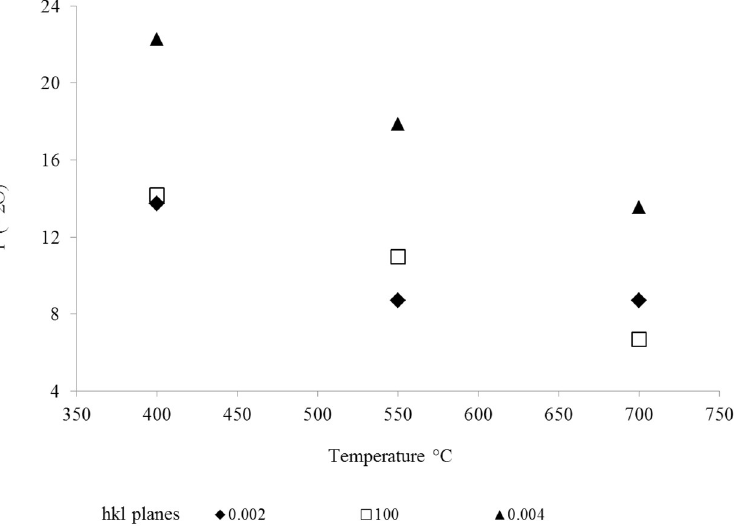
Fig 3. Width of the base of the peak to half-height in 2 Ɵ for the hkl planes (002), (004), and (100).